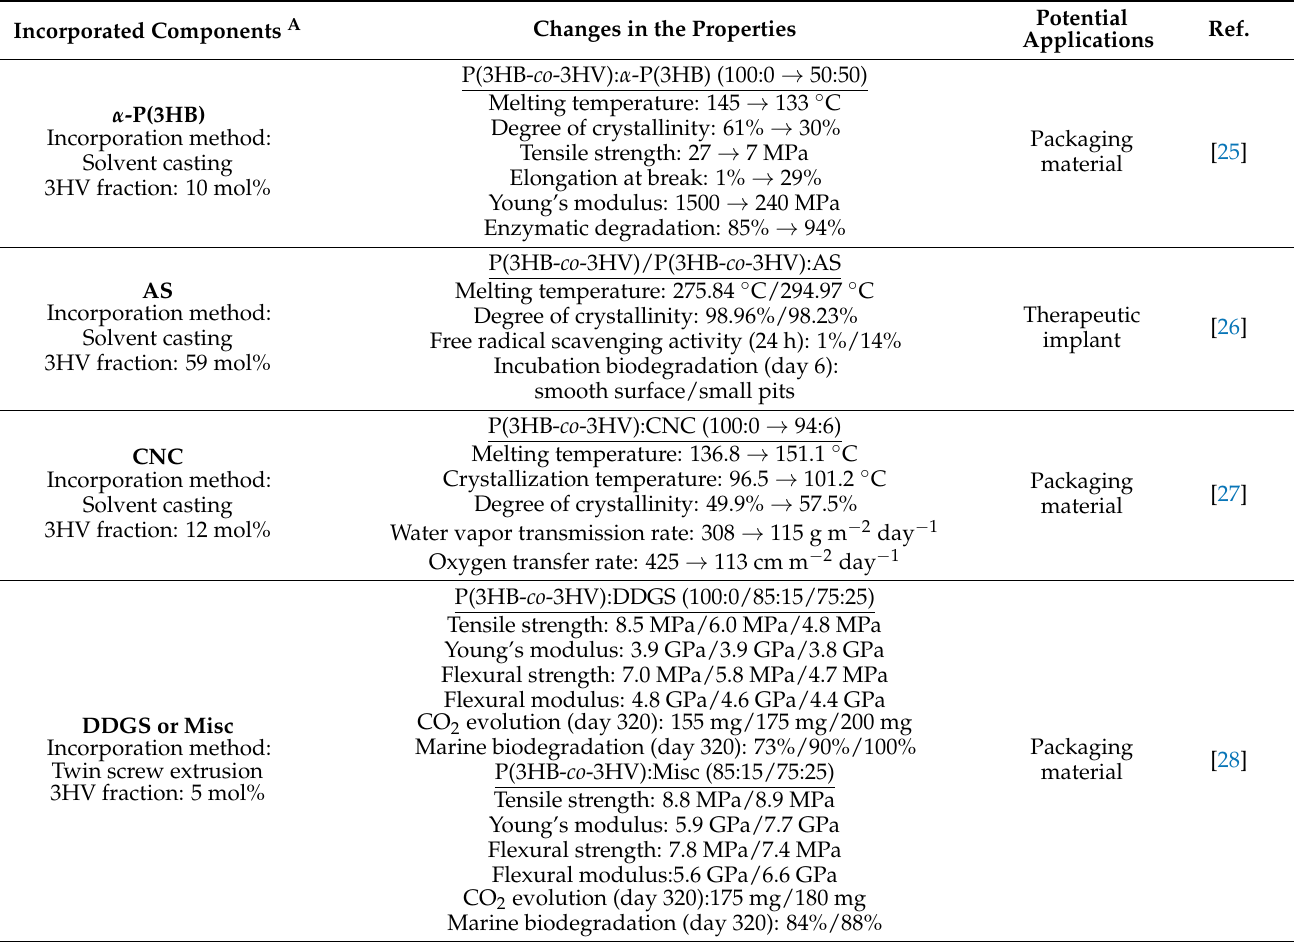
Figure 1. Microbial PHA granule, P(3HB- co -3HV) structure, and applications. Table 1. Properties improvement after the incorporation of a secondary (and tertiary) component into P(3HB- co -3HV) and their potential applications.